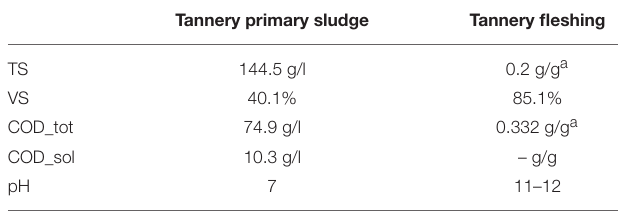
TABLE 2 | Substrate